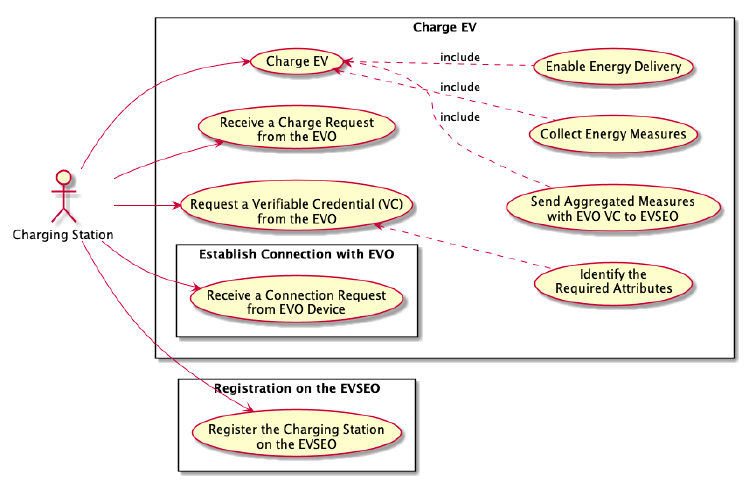
Figure 15. Use cases implemented by the Charging Stations (CS).